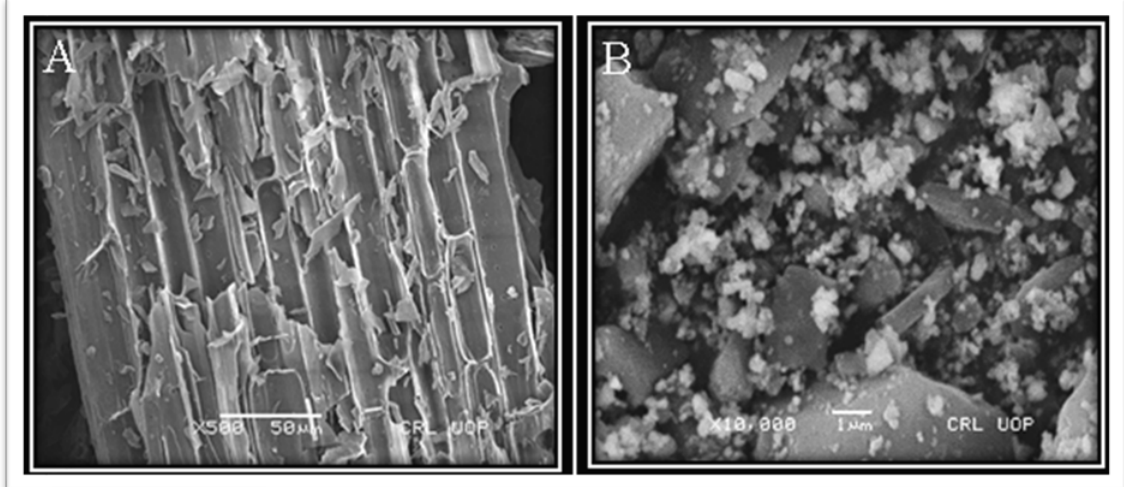
Figure 5. SEM micrographs of pristine MB ( A ) and MB-ZnO ( B ).